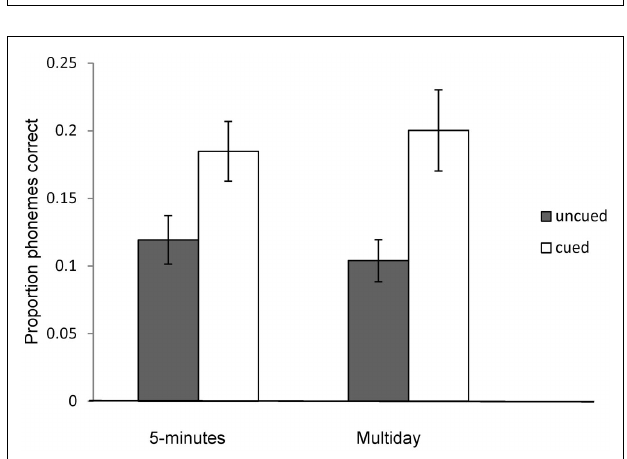
FIGURE 3 | Mean proportion syllables correct for uncued production attempts across time intervals.